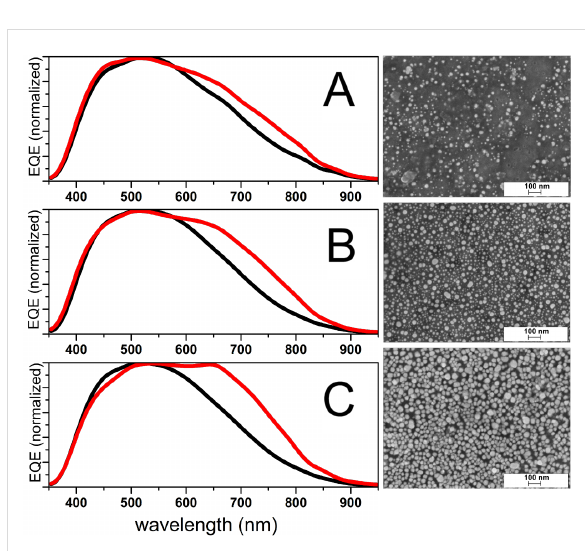
Figure 3: Left: External quantum efficiency (EQE) of ITO/ ZnO/In 2 S 3 /CuInS 2 /Au-NP solar cells (red line) and EQE of the solar cells without the Au-NP layer (black lines). The volume of the Au-NP precursor solution was 2.5 mL (A), 5 mL (B) or 10 mL (C). Right: SEM images of the CuInS 2 /Au-NP surface aligned with the corresponding EQE. Note that the EQE graphs have been normalized to emphasize the relative gain of the EQE. The overall EQE decreased when 5 mL or 10 mL of the Au-NP precursor solution was